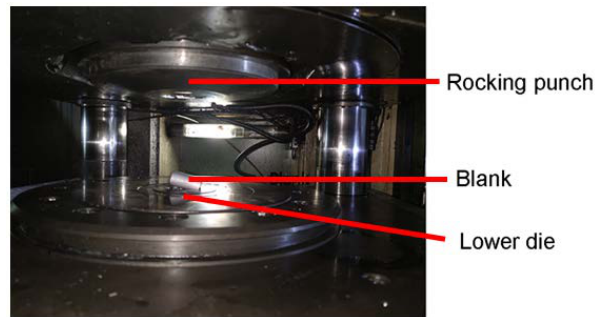
Figure 7. Experimental set up for cold orbital forming of AA6063 component.